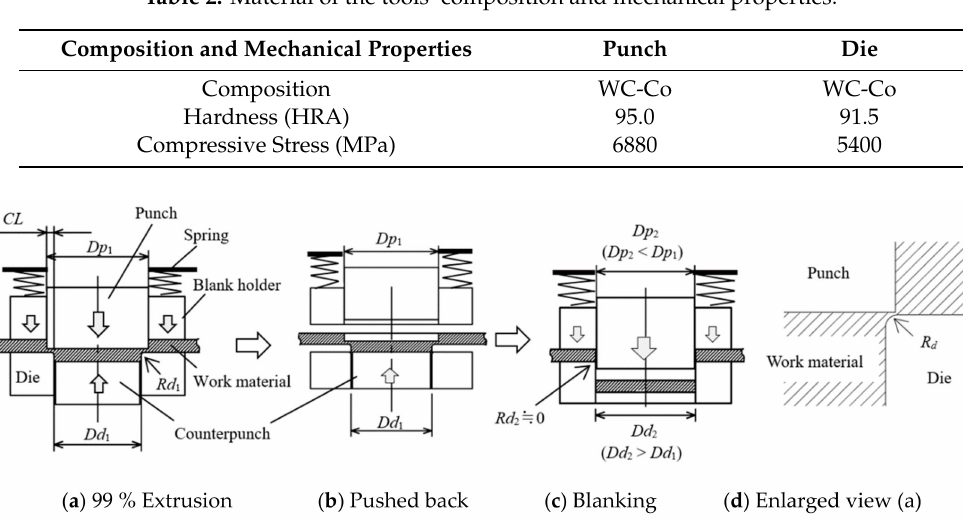
Table 2. Material of the tools’ composition and mechanical properties.